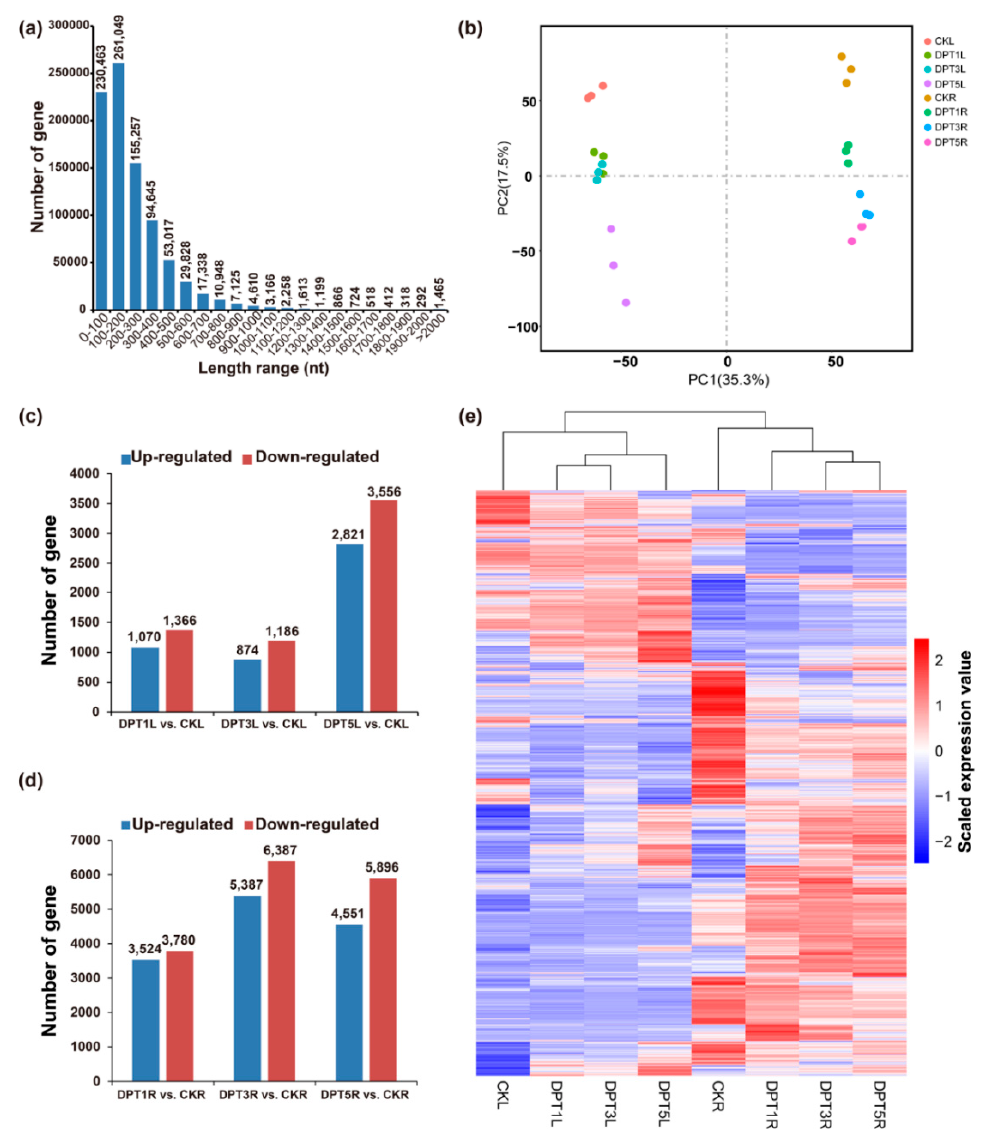
Figure 3. Overview of the transcriptomic results and changes in gene expression profiles in cotyledons and roots after drought stress treatment. ( a ) Predicted length distribution map of coding sequence (CDS)-encoded protein nucleotide (nt). ( b ) Principal component (PC) analysis of gene expression at di ff erent drought stress conditions. ( c ) Numbers of di ff erently expressed genes (DEGs) in cotyledons of common buckwheat seedlings at di ff erent drought stress conditions in pairwise comparisons. ( d )